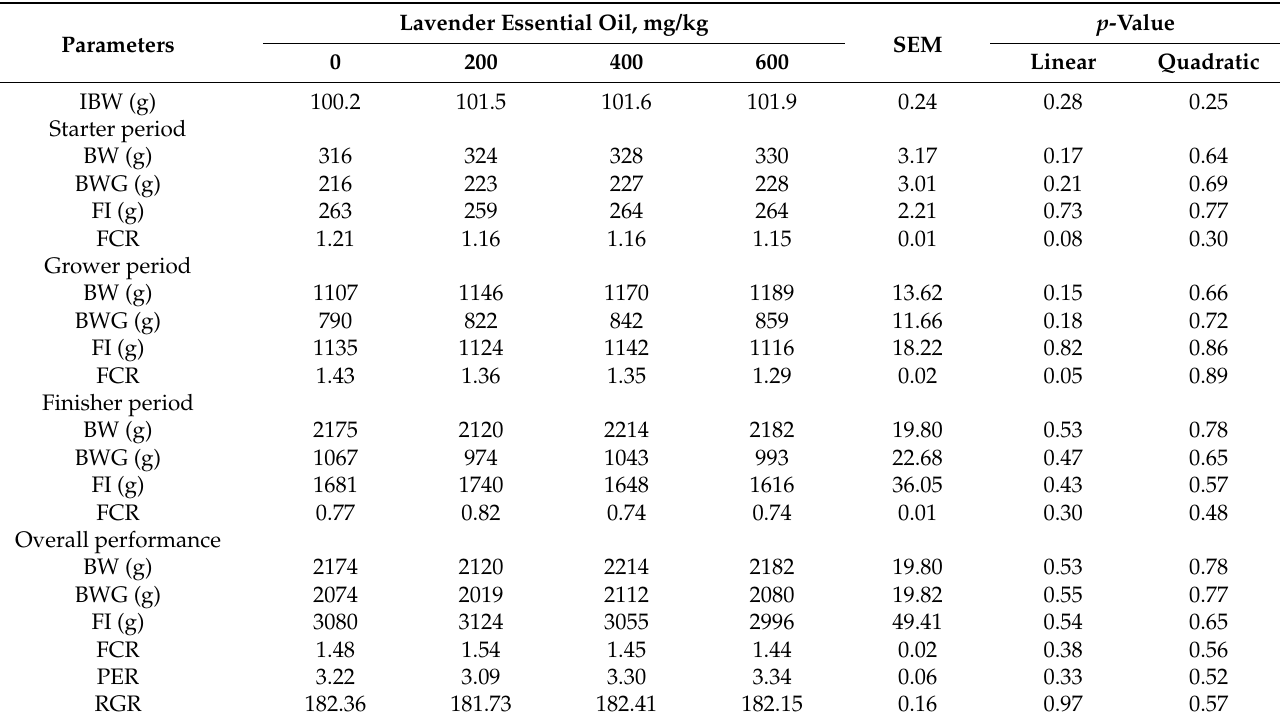
Table 3. Impact of lavender essential oil addition on the growth of broiler chickens.